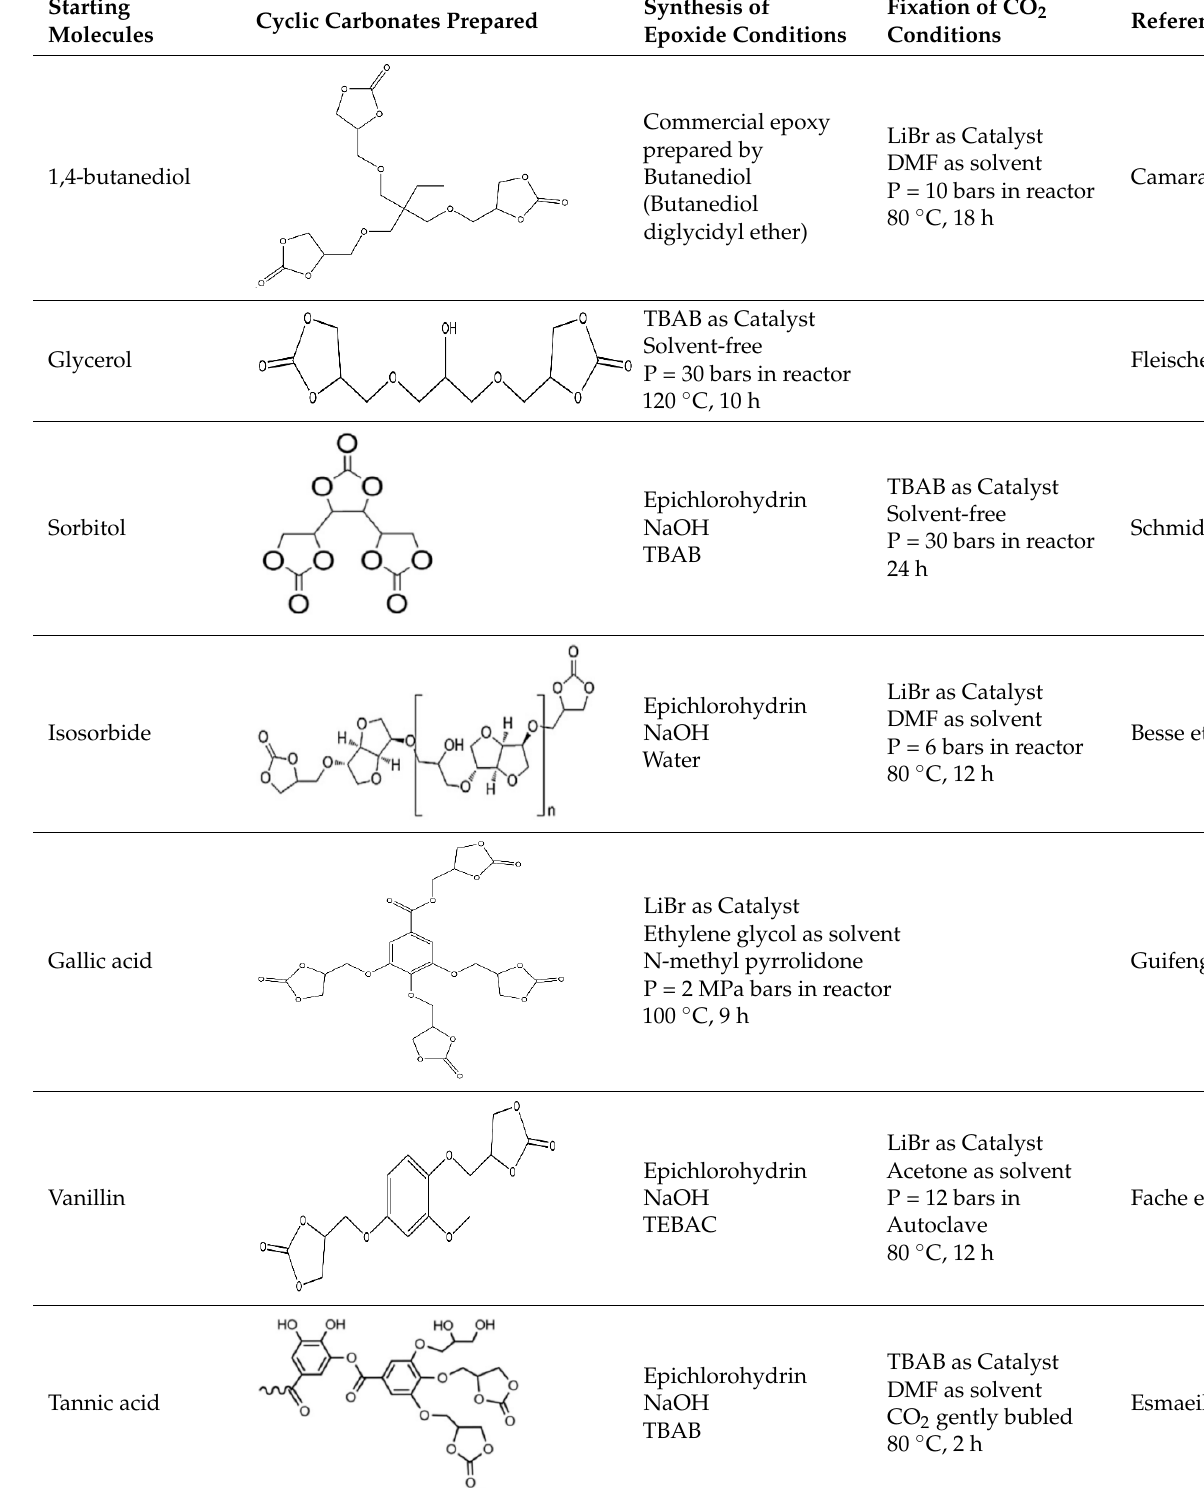
Table 1. Methods of preparation of biobased cyclic carbonate.